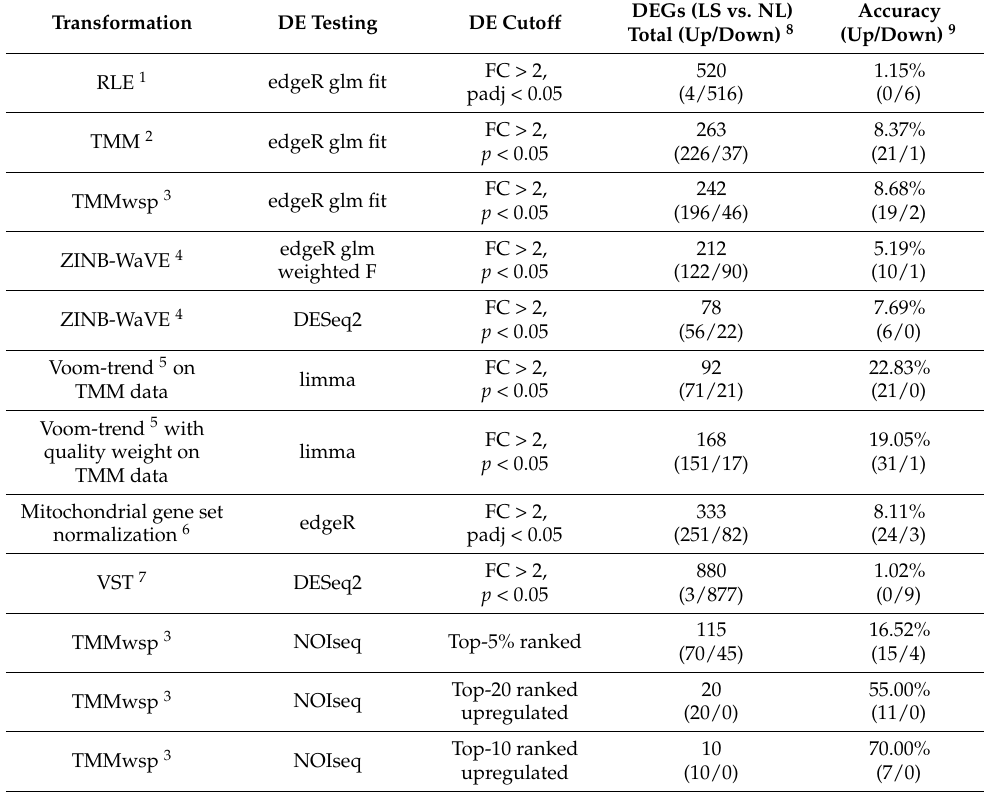
Table 1. Benchmark of counts transformation and differential expression (DE) testing